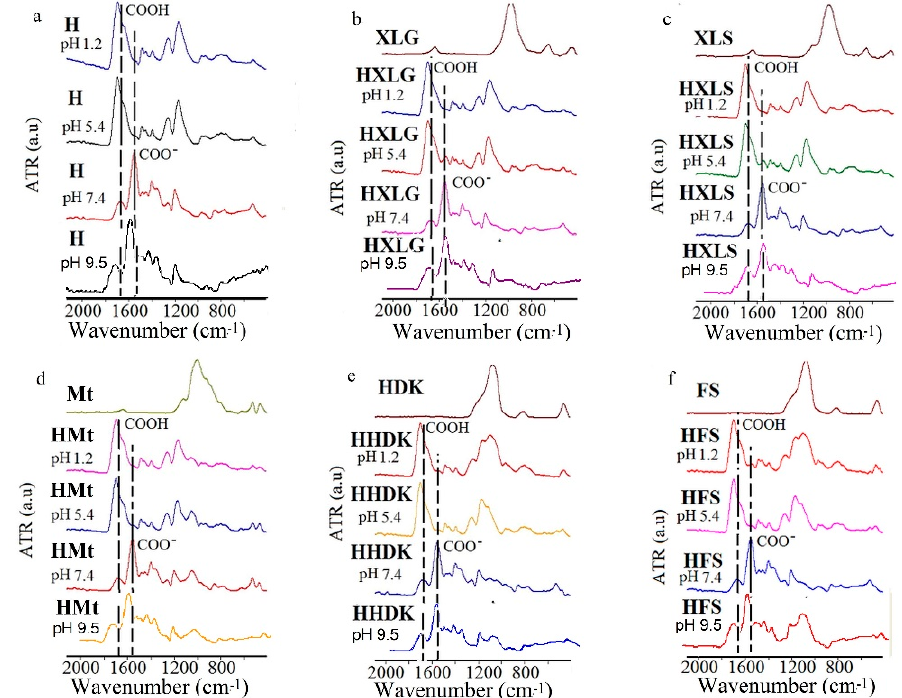
Figure 1. FT-IR spectra of (nano)composite hydrogels swelled at different pH values. ( a ) H; ( b ) HXLG; ( c ) HXLS; ( d ) HMt; ( e ) HHDK; ( f ) HFS.